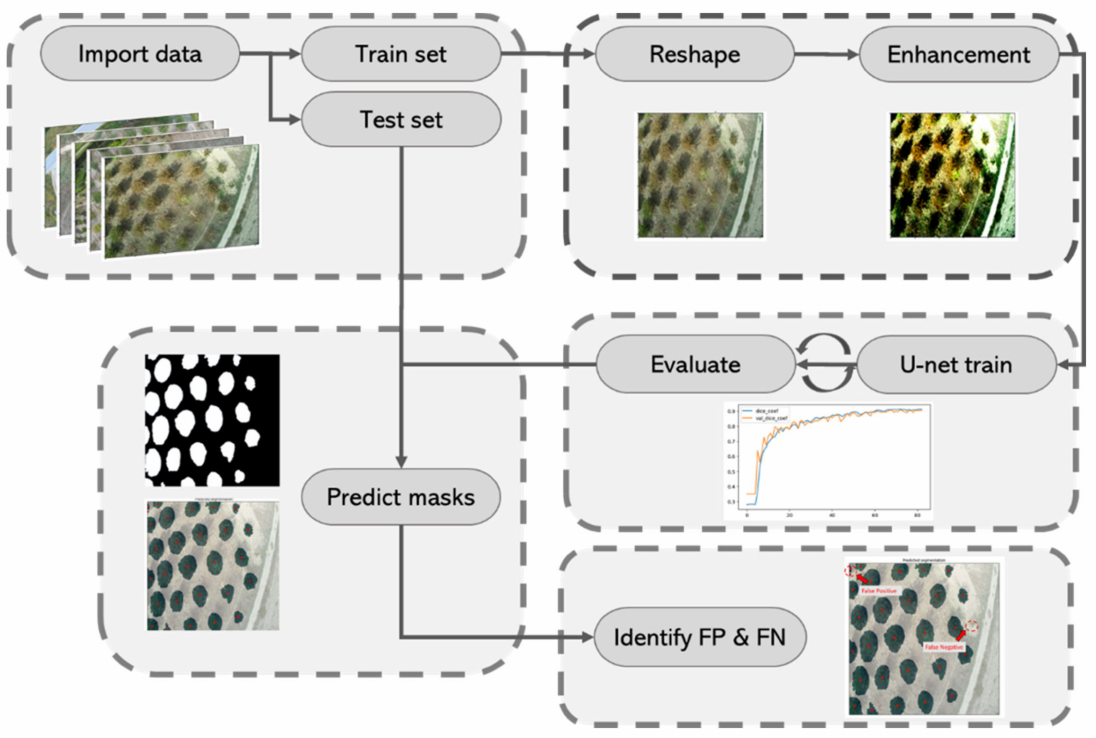
Figure 2. Process flow of the proposed methodology for creating segmentation predictions. FN: false negative; FP: false